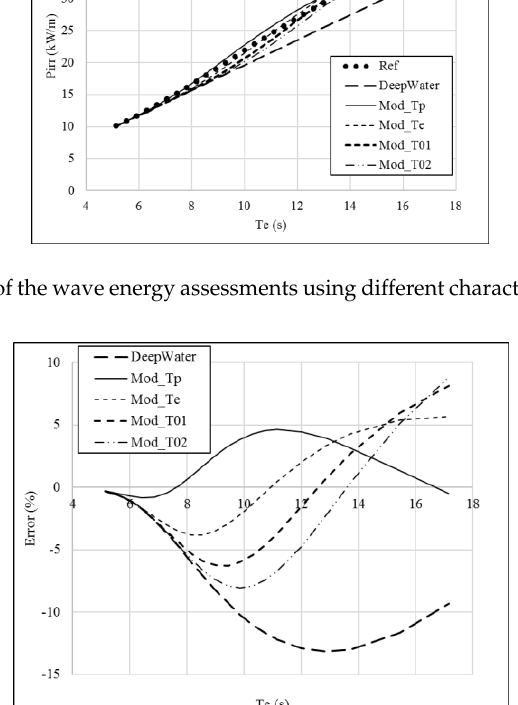
Figure 7. Errors for deep-water formulas and modifications using different periods ( h = 50 m).